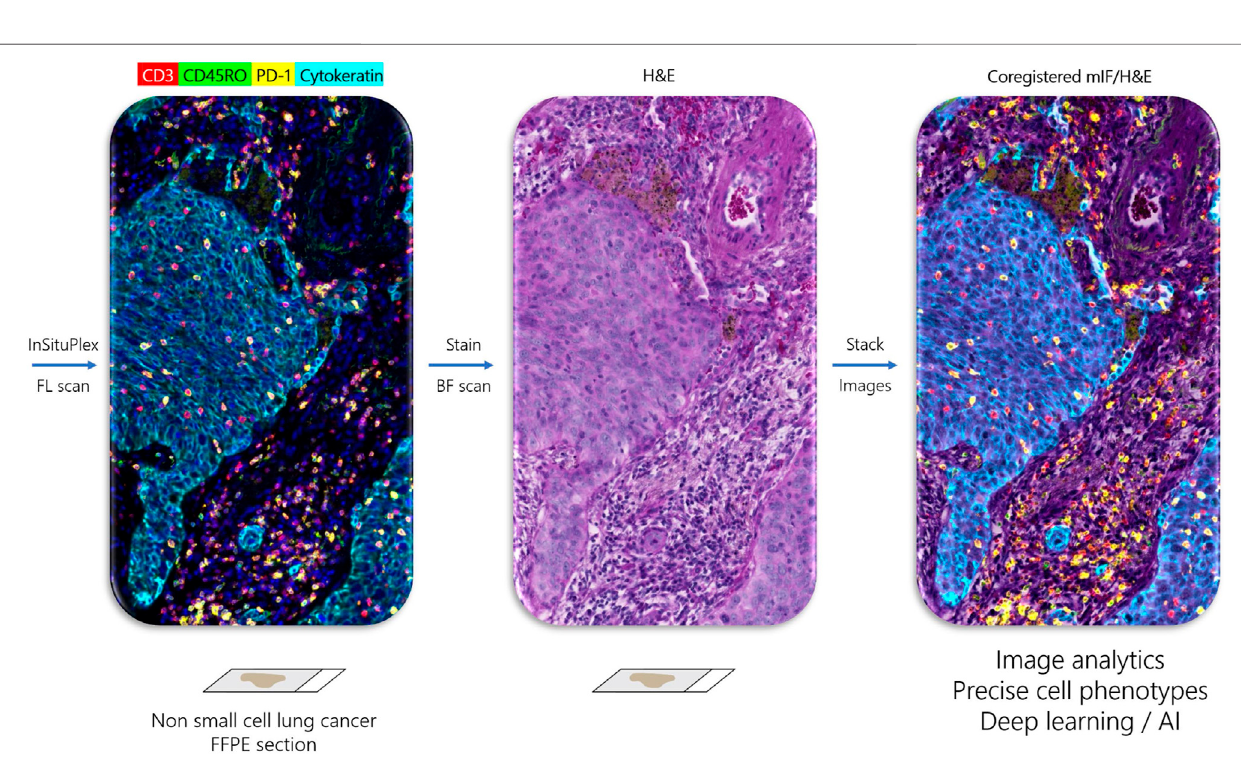
FIGURE2| Ultivue InSituPlex work fl owenables coregistration ofmultiplex IF and H&Etissueimages. Leftpanel shows image ofnon-small cell lung cancerstained withfour-marker panel including CD3 + T cells (red), CD45RO+memory Tcells (green), PD-1+ exhausted Tcells (yellow), and Cytokeratin positive carcinoma cells (cyan) obtained by fl uorescent (FL) scan. H&E stain on same section (middle panel) obtained by bright fi eld (BF) scan. Right panel is coregistered overlay of multiplex and H&E images, which allows assignment of marker phenotype to every cell in the H&E section, which may be used for integrated image analytics and training of deep learning